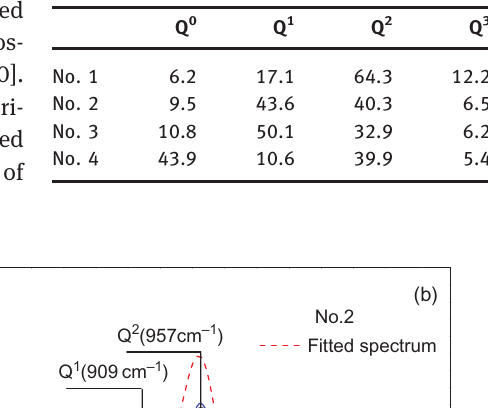
Table 4: The proportions of structural